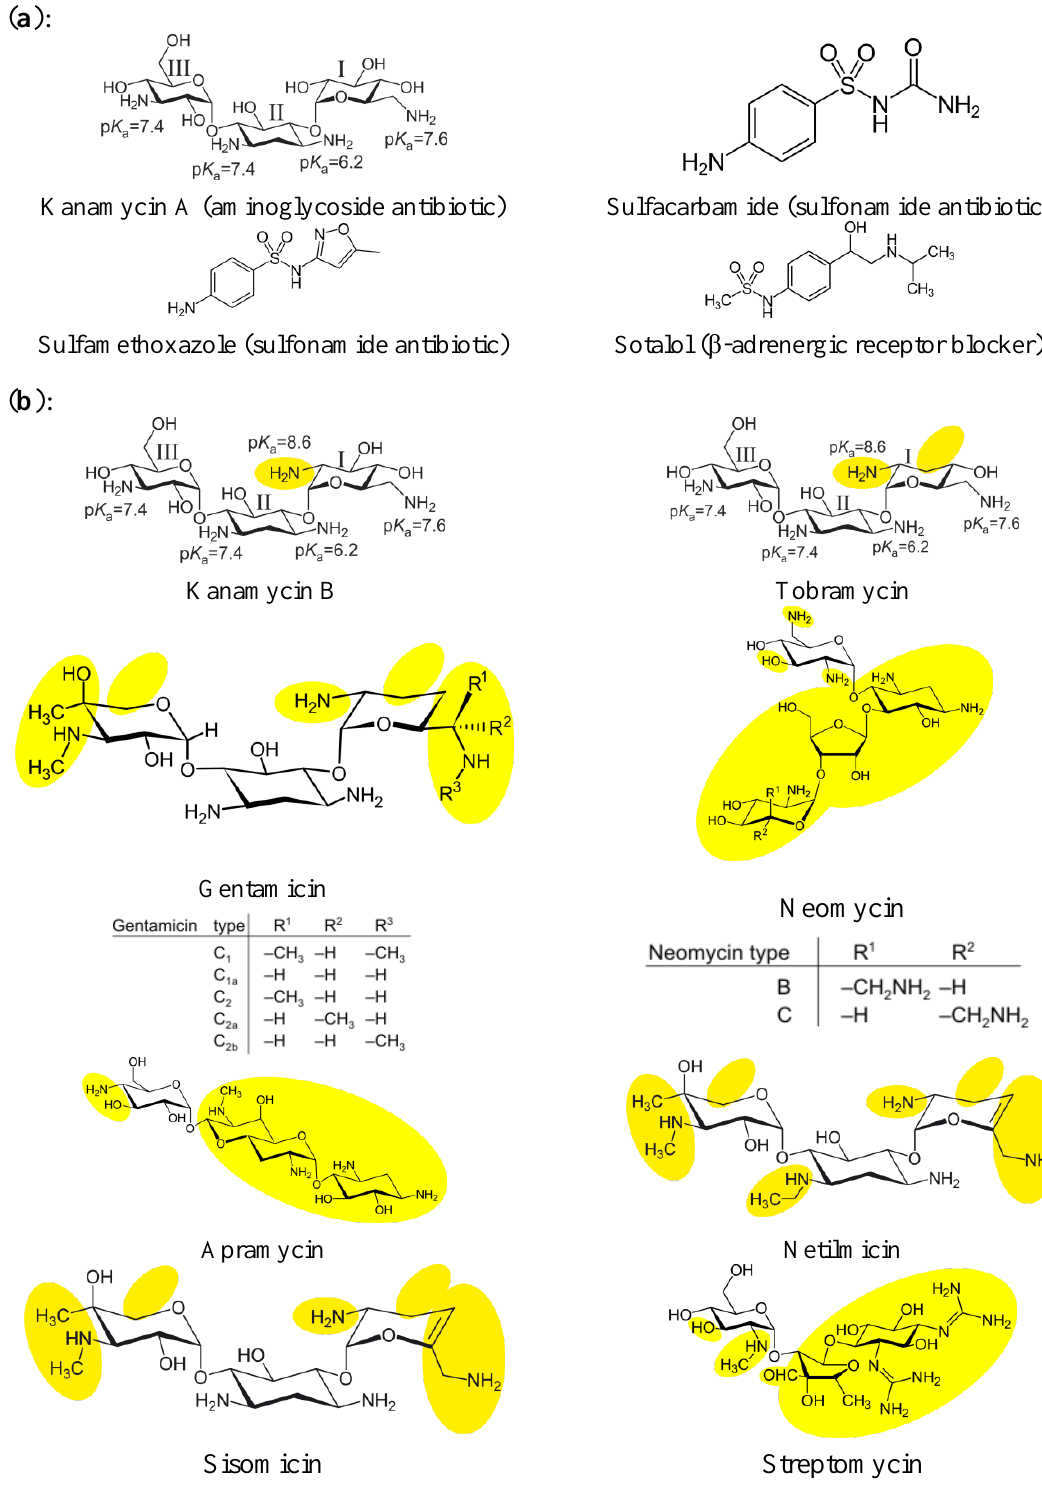
Figure 1. ( a ) Chemical structures of the selection targets. Numbering of the rings and p K a values of amino groups according to [13]; ( b ) Chemical structures of aminoglycoside antibiotics other than kanamycin A. Differences in the structure compared to kanamycin A are marked in yellow. Numbering of the rings and p K values of amino groups according to [13]; a ( c ) Chemical structures of amino sugars. Differences in the structure compared to kanamycin A are marked in